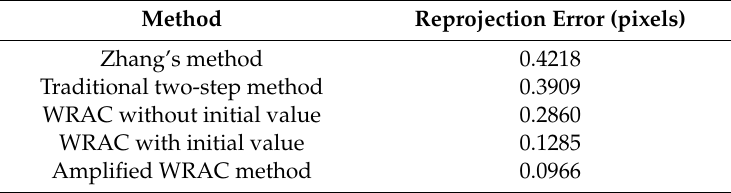
Table 3. Reprojection errors of Camera 1 using five calibration methods.